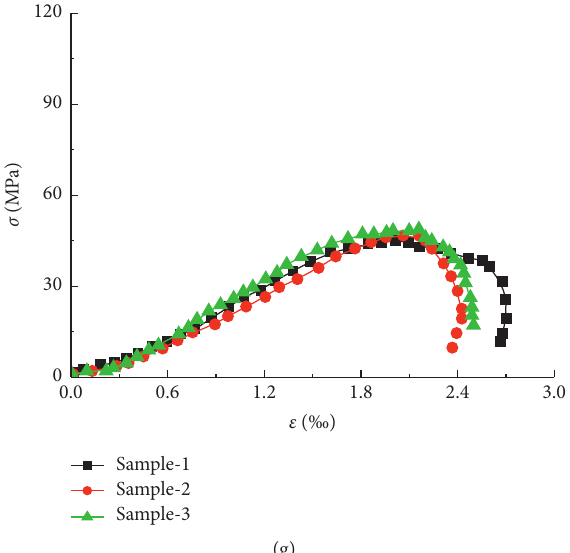
Figure 5: Stress-strain curves of samples with different moisture contents under dynamic loading: (a) ω � 0.00%, (b) ω � 2.01%, (c) ω � 2.23%, (d) ω � 2.40%, (e) ω � 2.49%, (f) ω � 2.53%, and (g) ω � 2.58%.